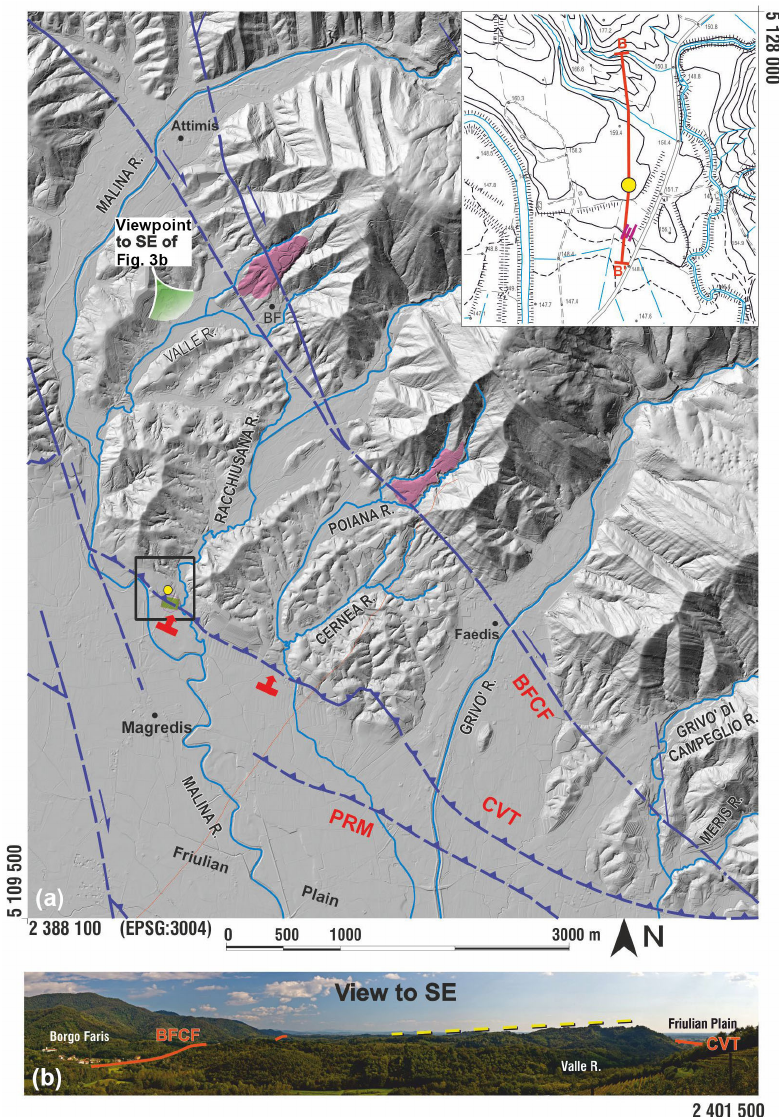
Figure 3. (a) Digital elevation model (supplied by Regione Friuli Venezia Giulia) of the study area. Faults: BFCF; CVT; PRM, Premariacco thrust; BF: Borgo Faris village. Back-tilted surfaces at the Racchiusana and Poiana valley outlets, red arrows. In pink are the two suspended Quaternary glacis cut off by the BFCF. The black square is detailed in the inset: site of the core logging, yellow dot; traces of the paleo- seismological trenches, violet lines; BB (cid:48) , geological section of Fig. 4. Red line: seismic line of Fig. 2. (b) The NE-dipping paleolandscape carved in the turbidite bedrock (yellow dotted line) between the BFCF and the CVT. Point of view in Fig. 3a (green